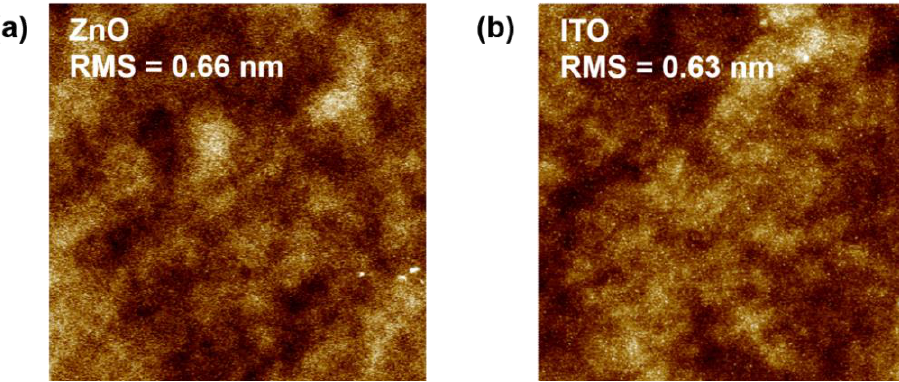
Figure 4. AFM images of ( a ) ZnO and ( b ) ITO films. ZnO and ITO films were deposited on Si sub- strates.